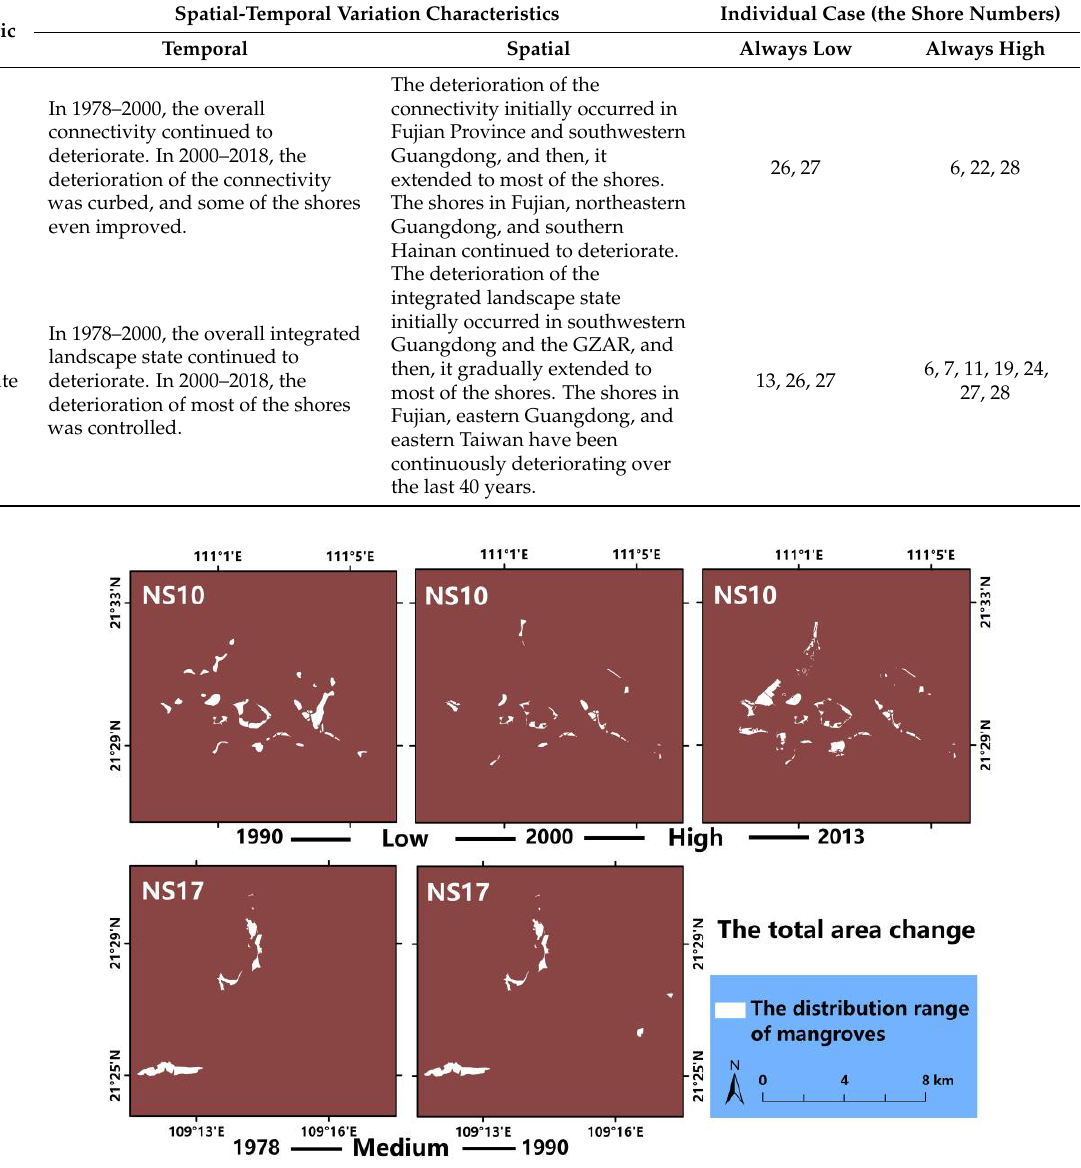
Figure 8. Mangrove patch changes for different levels of TA change.